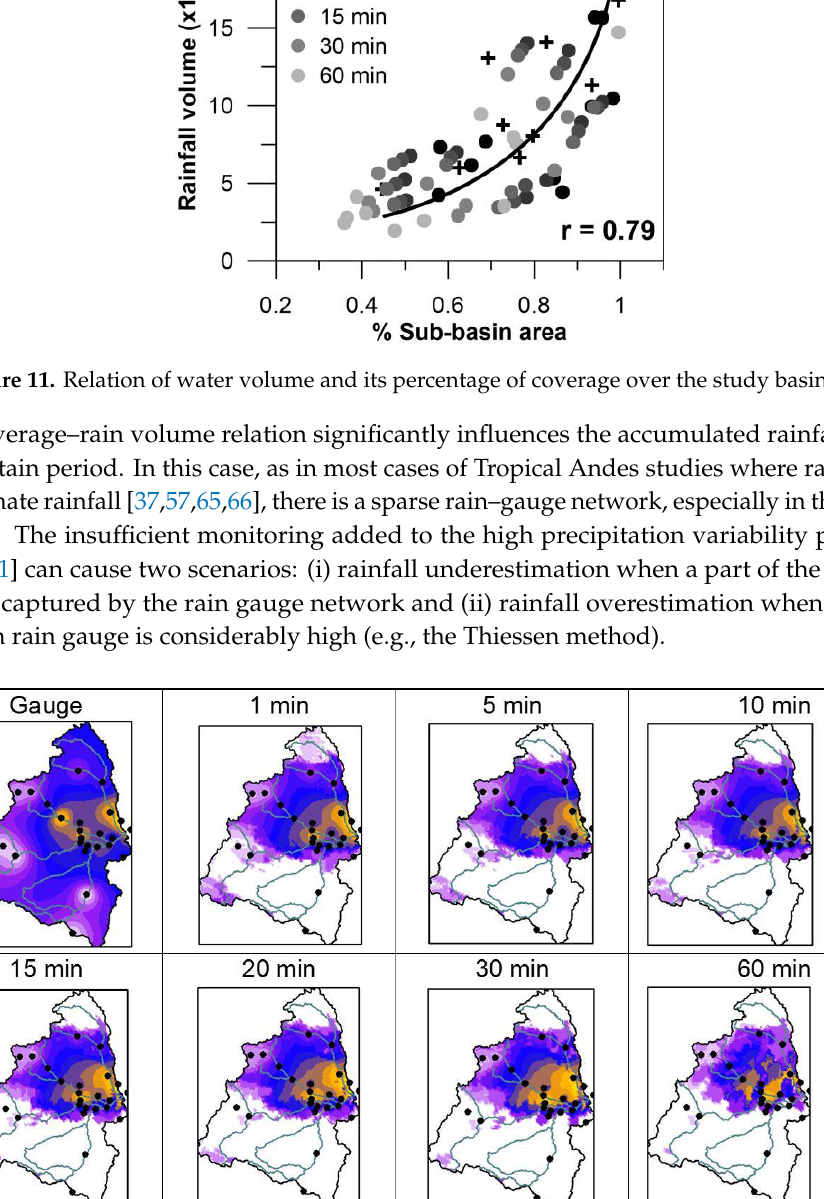
16 of 22 Figure 10. Accumulated rainfall volume (m 3 ) for the 11 events according to the different radar temporal and spatial resolutions. There is a remarkable relationship between the spatial rainfall coverage over the basin and the rain total volume (Figure 11). This relationship is not linear, because it depends on other event characteristics, such as intensity and duration [28]. In this case an exponential relation was found (r = 0.79). Nonetheless, the coverage percentages estimated with the rain gauge network differed from those estimated by the radar data. For instance, for the event on 04/17/2015, using only the rain gauge network data, the rainfall precipitated over 80% of the sub-basin ’s total area calculated with the